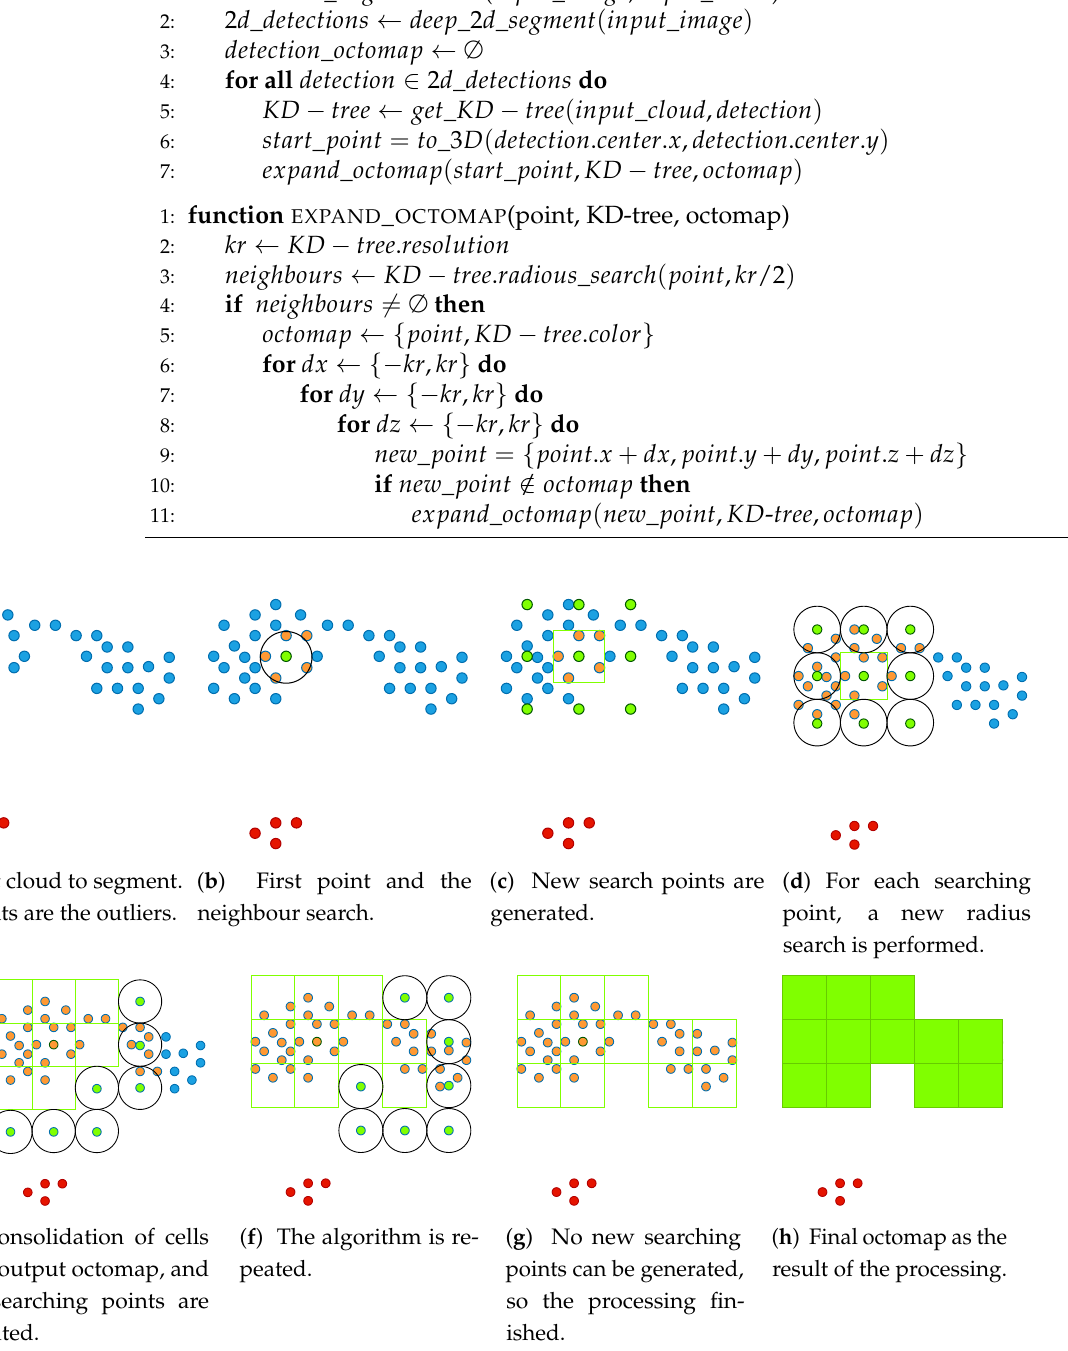
Figure 4. Example of the application of the algorithm with a simplification in